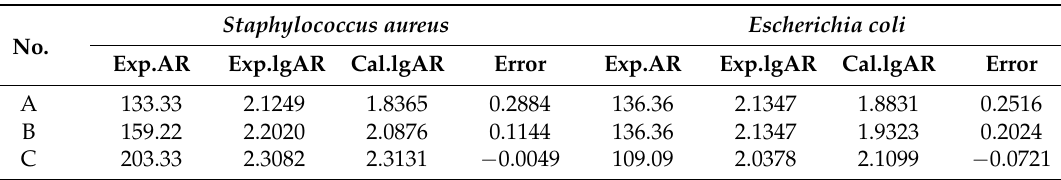
Table 4. The antibacterial activity rates and comparison of predicted values and experiment values for screened compounds A, B, and C at a concentration of 0.125 mol/L.